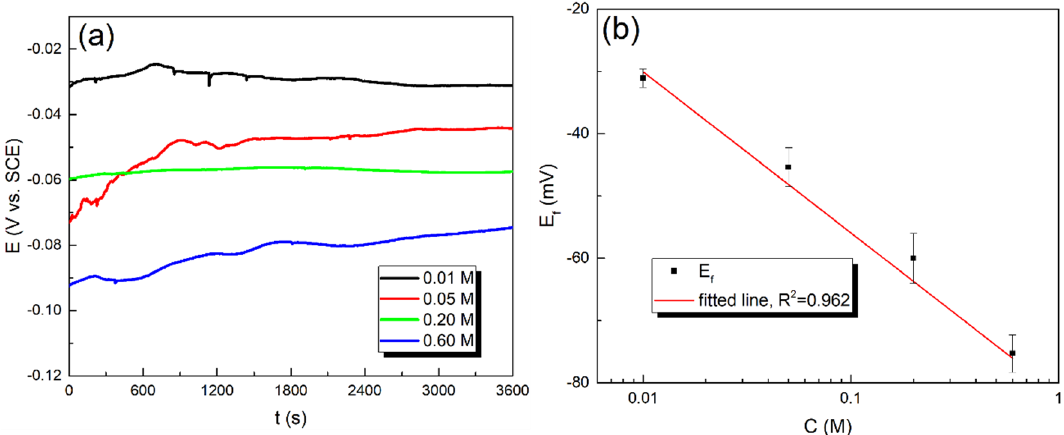
Figure 1. The variation of open circuit potential (OCP) with time for galena in different concentrations of NaCl solutions at pH 6.7 ( a ), and ( b ) the relationship between E f and